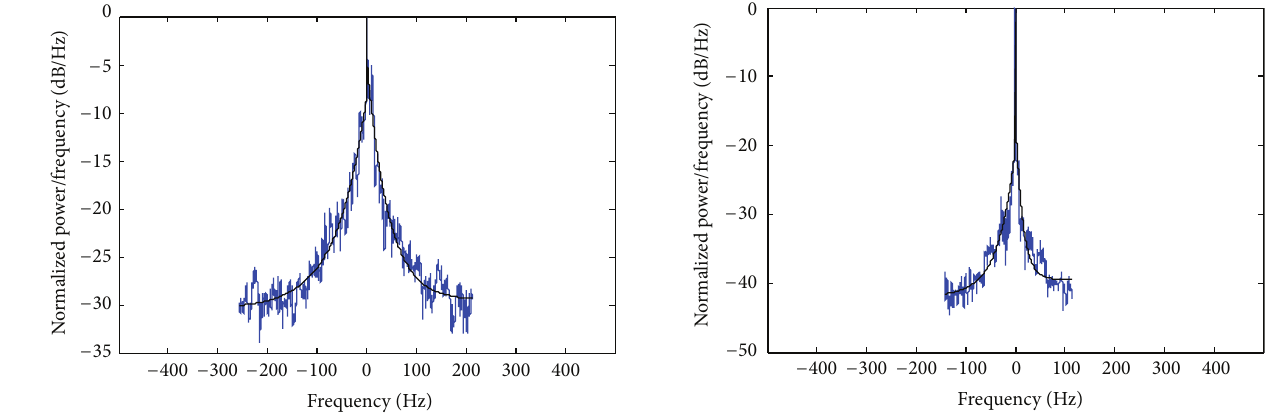
Figure 11: Example C: estimated PSD and corresponding exponen- tial fitting ( 𝑎 = 21.98 , 𝑏 = 1.65 ⋅ 10 −2 , 𝑐 = 30.39 , 𝑑 = 25.09 , 𝑒 = 2.33 ⋅ 10 −2 , 𝑔 = 29.53 , 󳵻𝑓 = 468.29 , and 𝛾 = 0.09 ).